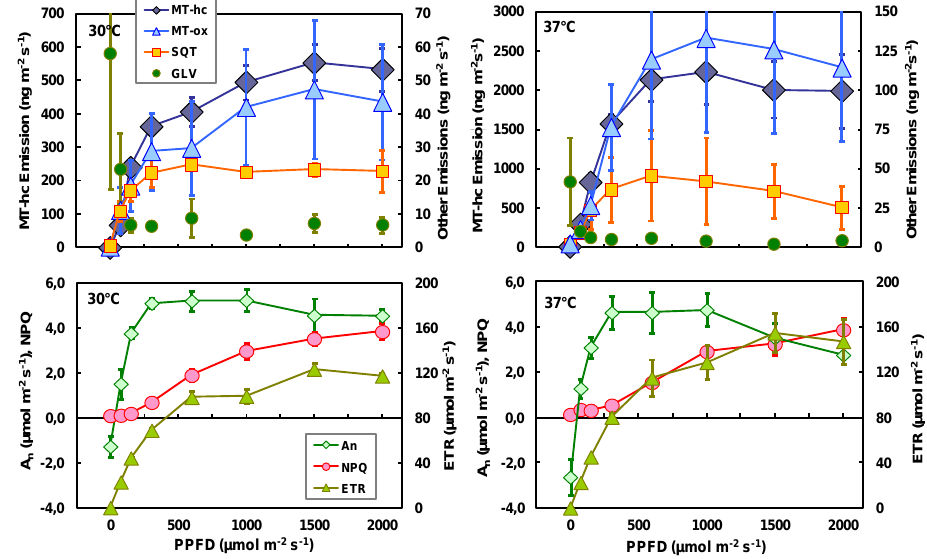
Fig. 1. Light responses of BVOC emissions (upper panels) and photosynthetic parameters (lower panels) of Q. coccifera leaves measured at two temperature levels of 30 ◦ C (left panels) and 37 ◦ C (right panels). Dark blue lozenges: monoterpene hydrocarbons (MT-hc); bright blue triangles: oxygenated monoterpenes (MT-ox); yellow squares: sesquiterpenes (SQT); dark green circles: green leaf volatiles (GLV); dark green lozenges: photosynthesis ( A n ); green triangles: apparent photosystem II electron transport rate (ETR); red dots: non photochemical quenching (NPQ). Data are means ± SD of n =3–4